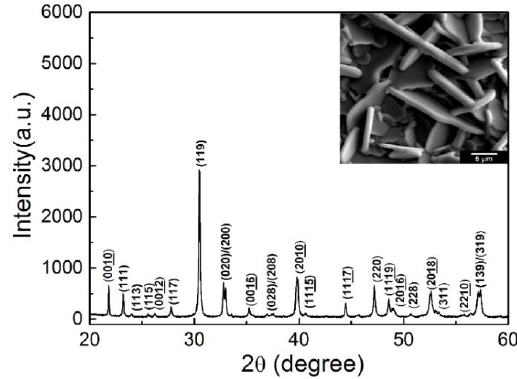
Figure 1. The X-ray diffraction pattern and scanning electron microscopy (SEM) image (embedded) of the Co-doped Na 0.5 Bi 4.5 Ti 4 O 15 (NBT-Co) sample.